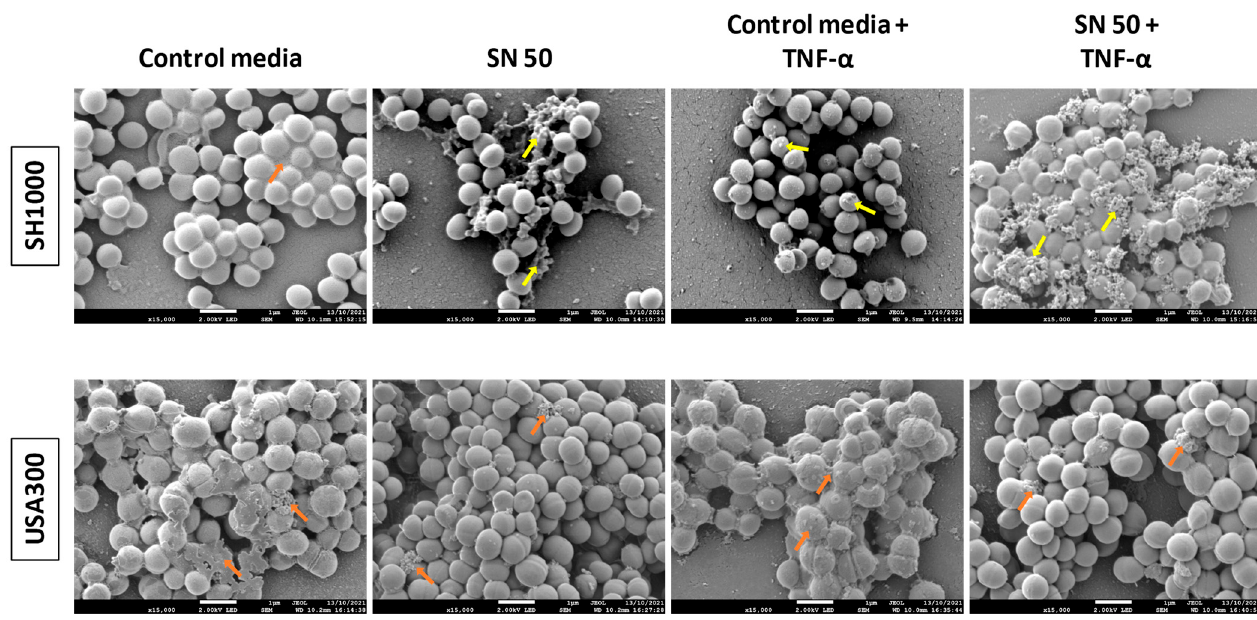
Figure 3. Impact of Saos-2 culture supernatant on S. aureus biofilm shape and matrix. One representative image for two batches is shown. Control media (50% [DMEM + 10% FBS] and 50% MM), SN 50 (50% Saos-2 culture supernatant and 50% MM), Control media + TNF- α (50% [DMEM + 10% FBS + 20 ng/mL TNF- α ] and 50% MM), or SN 50 + TNF- α (50% [Saos-2 challenged with TNF- α culture supernatant + 20 ng/mL] and 50% MM). Orange arrows indicate bacterial matrix. Yellow arrows indicate microvesicles-like structure. One coverslip was imaged for two different batches of Saos-2 culture supernatant and the corresponding control media. The scale bars indicate 1 µm.